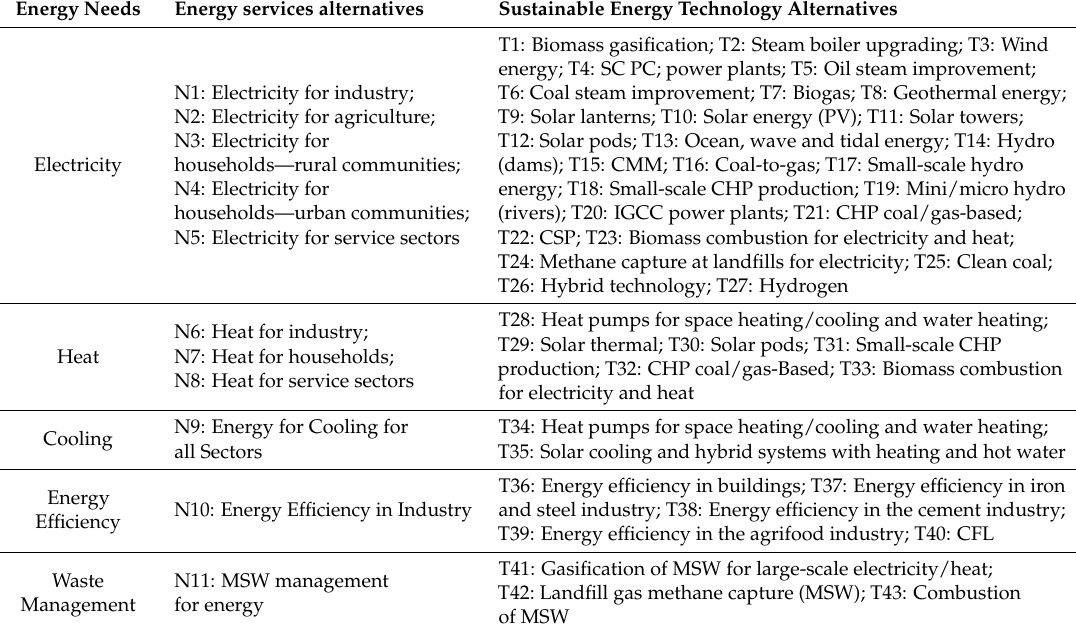
Table 1. The alternative sustainable energy technologies [7,45–52]. SC: supercritical; PC: